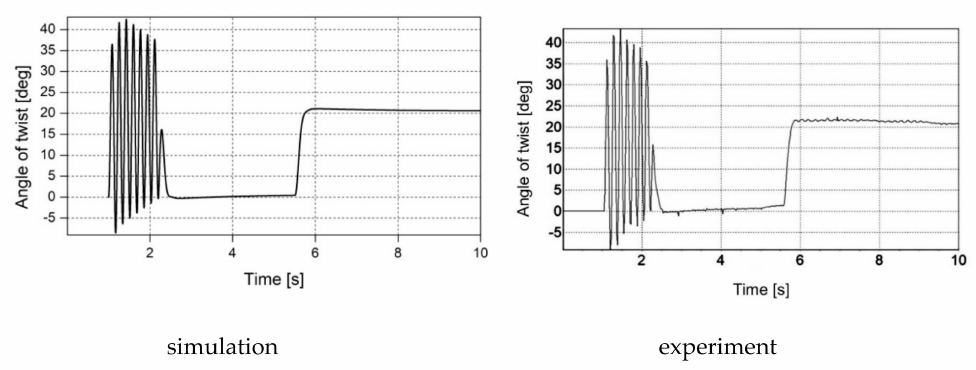
Figure 11. Angle of twist vs. time.